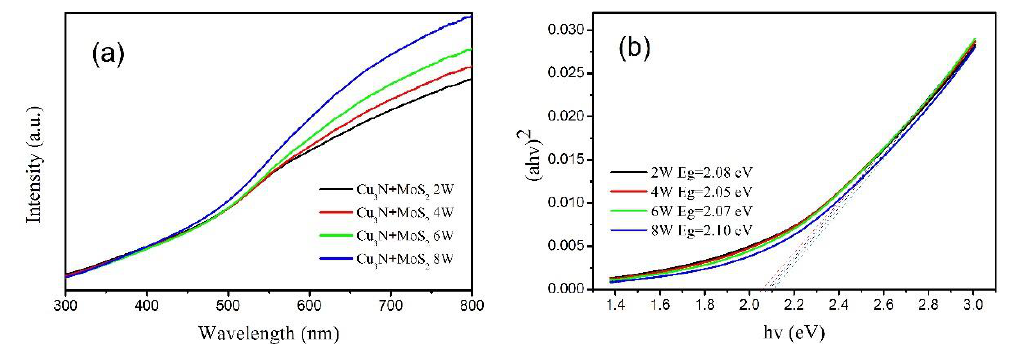
Figure 5. ( a ) UV – Vis transmission spectrum of the Cu 3 N/MoS 2 composite films, ( b ) determination of optical band gap of the Cu 3 N/MoS 2 composite films.